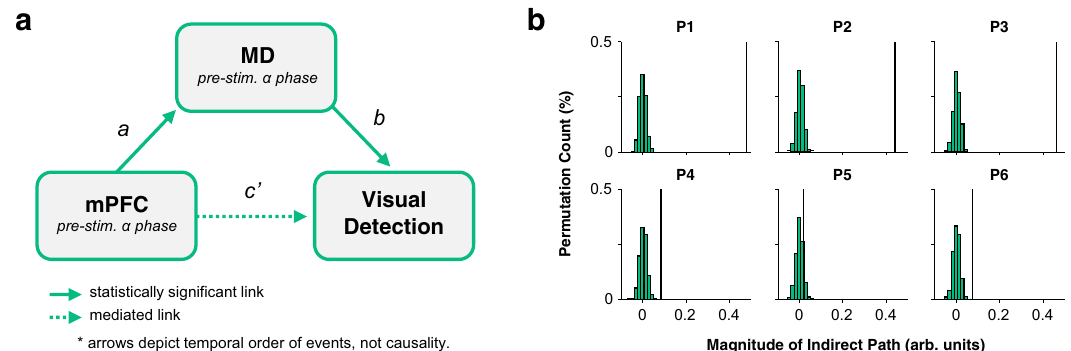
Fig. 3 Mediodorsal thalamic phase bifurcation mediates prefrontal contributions to visual detection. a Visualisation of the proposed mediation model. Pre-stimulus low-frequency phase patterns within the medial prefrontal cortex predict visual perceptual performance both directly and/or indirectly via the mediodorsal thalamus. Statistical analysis suggests that the indirect pathway ( ab) better predicts behavioural performance than the direct pathway. b The predictive power of the observed indirect path ( ab , black line) on behavioural performance relative to chance (green histogram bars; n = 1000 permutations). MD mediodorsal thalamus, mPFC medial prefrontal cortex. Source data are provided as a Source Data fi le.